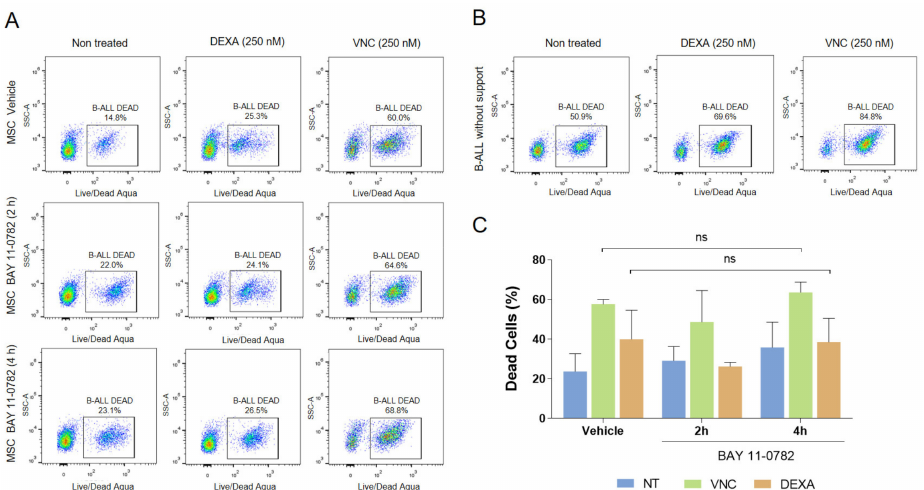
Figure 4. NF- κ B inhibition slightly alters the support conferred to B-ALL cells by MSC without increasing the sensitivity of leukemic cells to chemotherapy. ( A ) Changes in B-ALL cell viability after inhibition of NF- κ B in MSC support. MSC were treated for 2 or 4 h with BAY inhibitor (10 µ M), and co-cultured with leukemic cells pre-treated or not (NT) with VNC or DEXA (250 nM) for 6 h. B-ALL cells viability was evaluated after 72 h of co-culture. LIVE/DEAD Aqua positive cells (in squares) correspond to dead cells and were defined based on the unlabeled counterpart. ( B ) B-ALL cells without support and treated with the respective drugs were also included as controls. ( C ) Quantification of B-ALL cells viability in co-cultures according to the indicated treatments. Data are expressed as mean ± SEM ( p values: Non parametric one-way ANOVA. ns: Non-significant) from two independent